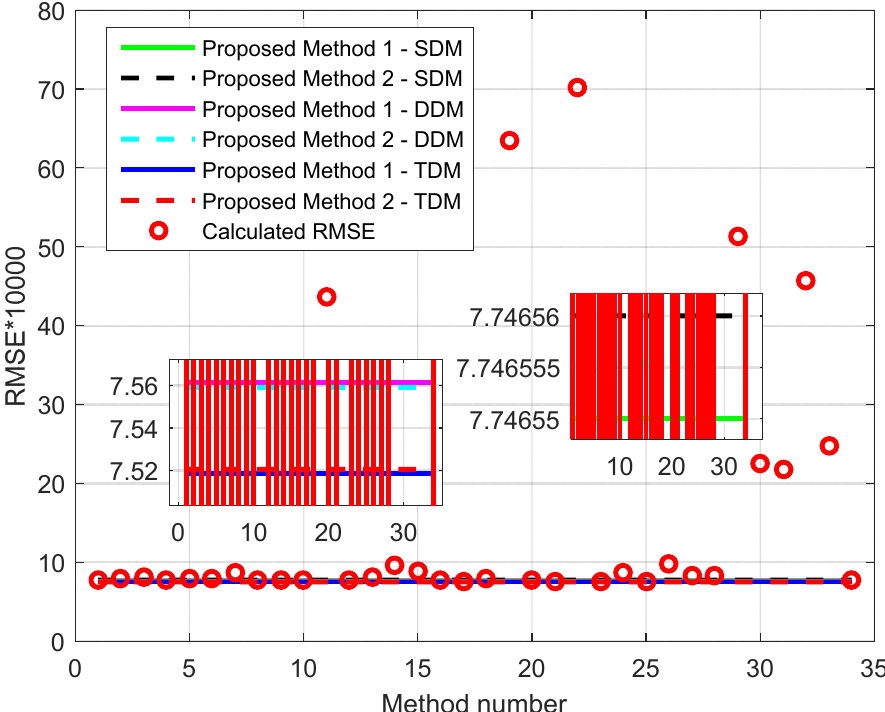
Figure 2. RMSE comparison for methods used to estimate the RTC France solar cell parameters.